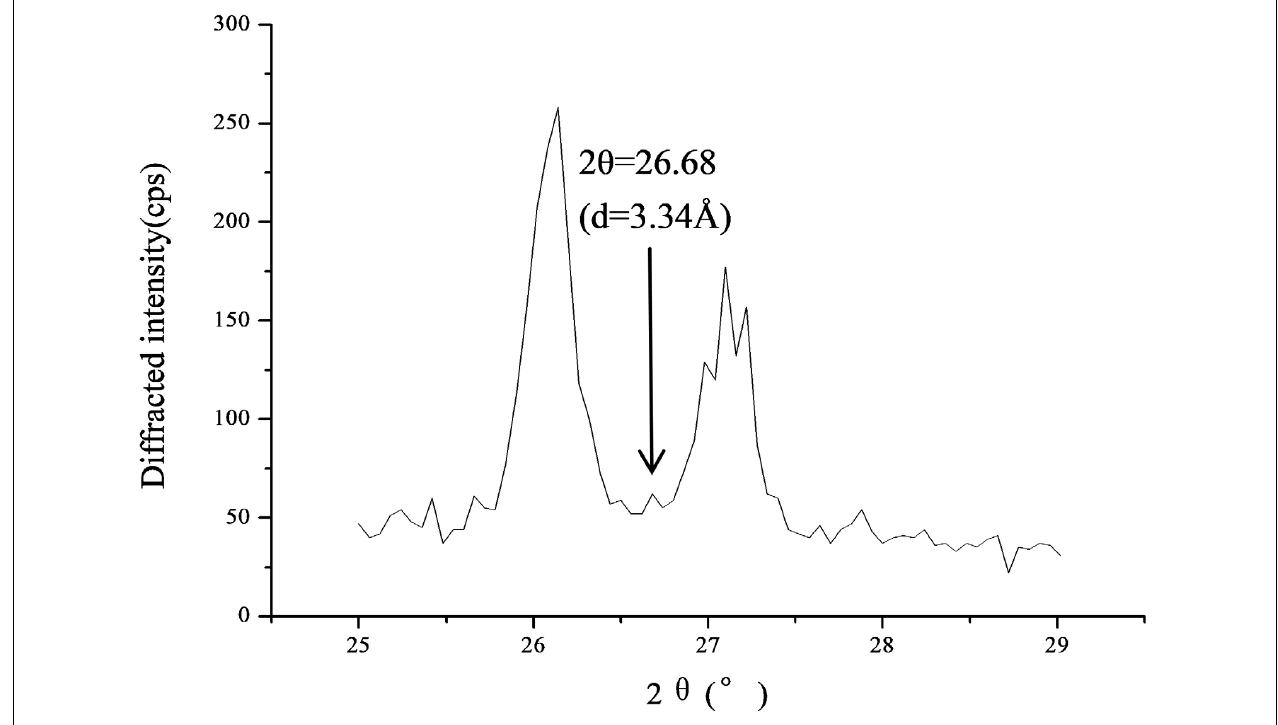
FIGURE 7 | X-ray diffraction pattern of shells with